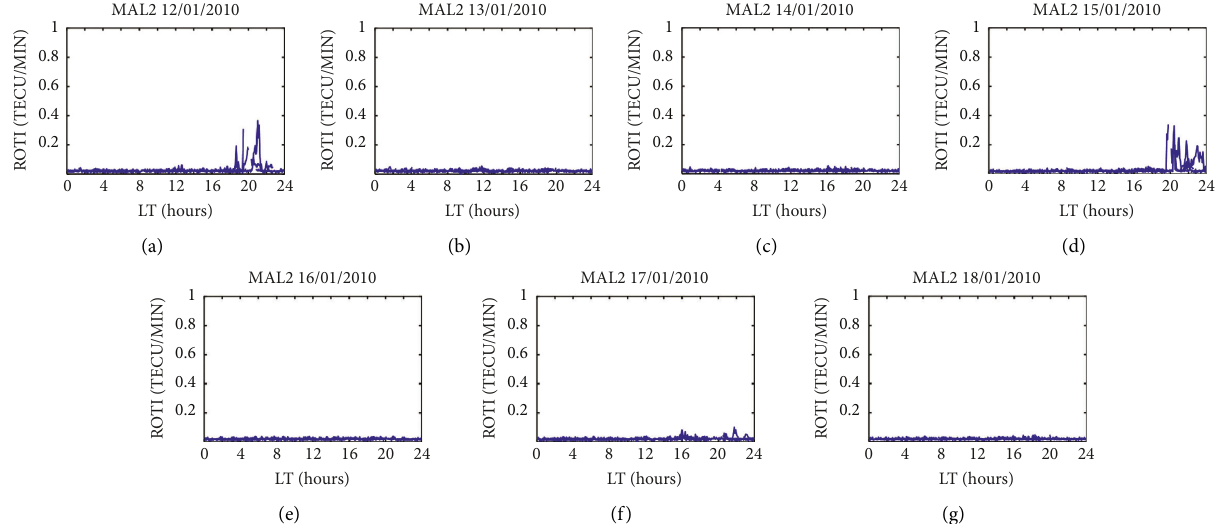
Figure 14: ROTI against LTover MAL2 station for (a) 12 th January 2010, (b) 13 th January 2010, (c) 14 th January 2010, (d) 15 th January 2010, (e) 16 th January 2010, (f) 17 th January 2010, and (g) 18 th January